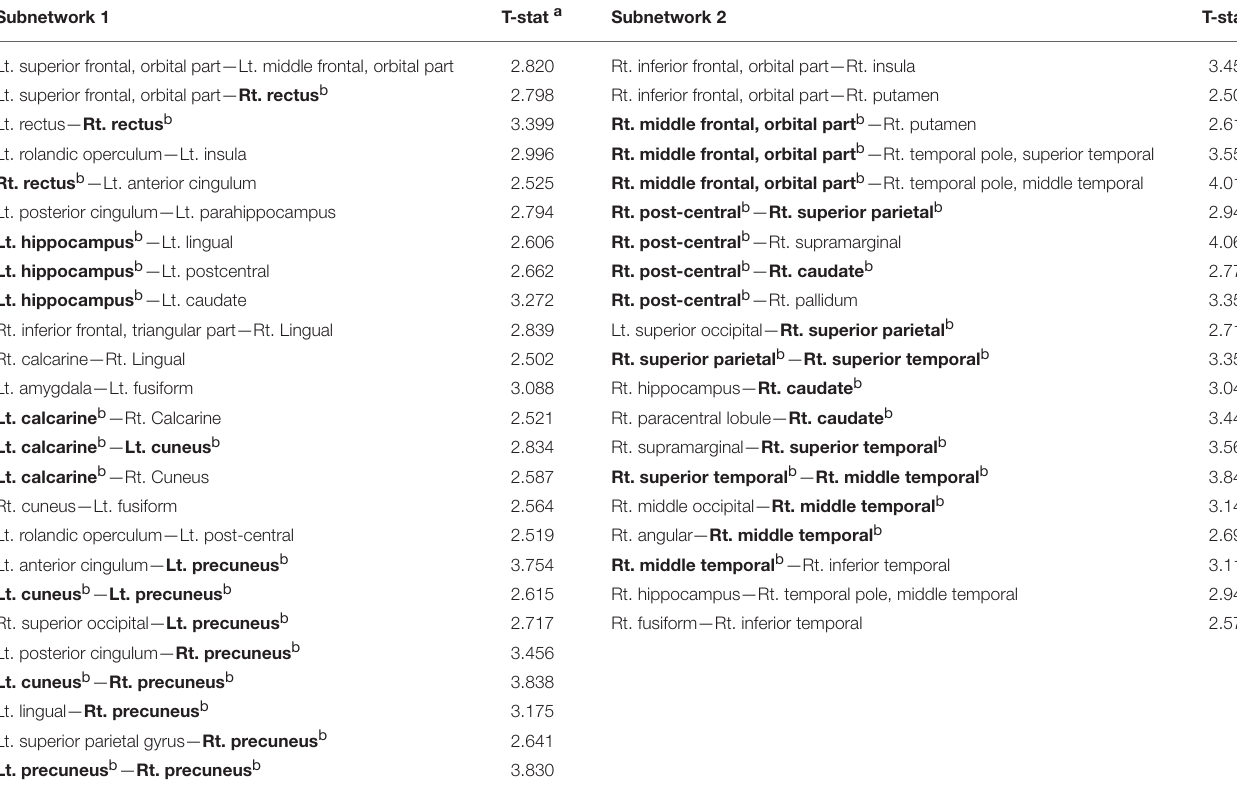
TABLE 4 | The subnetworks of reduced connectivity in NMOSD patients identified through network-based statistics